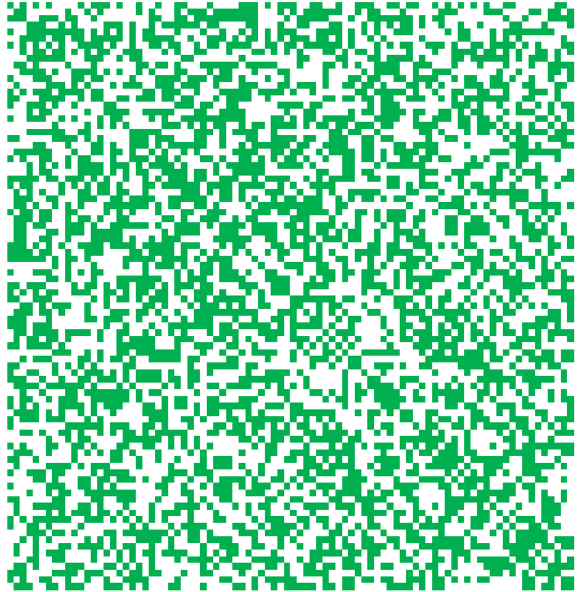
Figure 3. First-contact matrix for 15.482 Fall 2020 students. Cells ( i , j ) highlighted in green represent class-facilitated contact between students i and j at some point during the